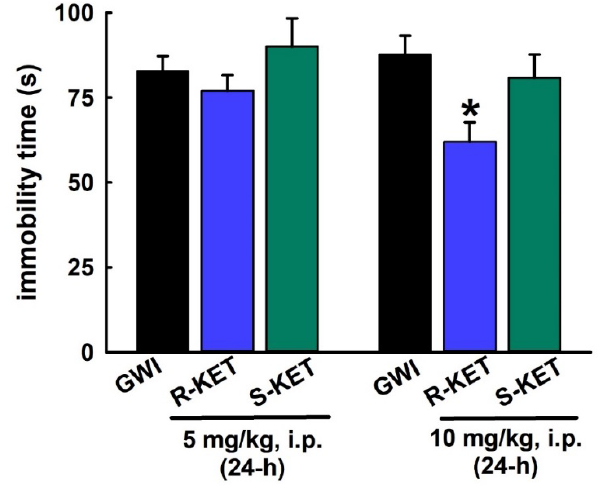
Figure 8. Sustained e ff ect of R -KET and S -KET on the FST behavior in a DFP rat model for GWI Separate cohorts of GWI rats were tested on FST at 24 h post-injection. The 5 mg / kg dose of R -KET and S -KET were not e ff ective in exhibiting significant reductions in the immobility times at 24 h post-injection. Only R -KET (10 mg / kg, i.p.) produced a significant reduction in the immobility time at 24 h (data expressed as mean ± SEM immobility, * p < 0.05, t -test, compared to GWI immobility, n = 7 rats / group).